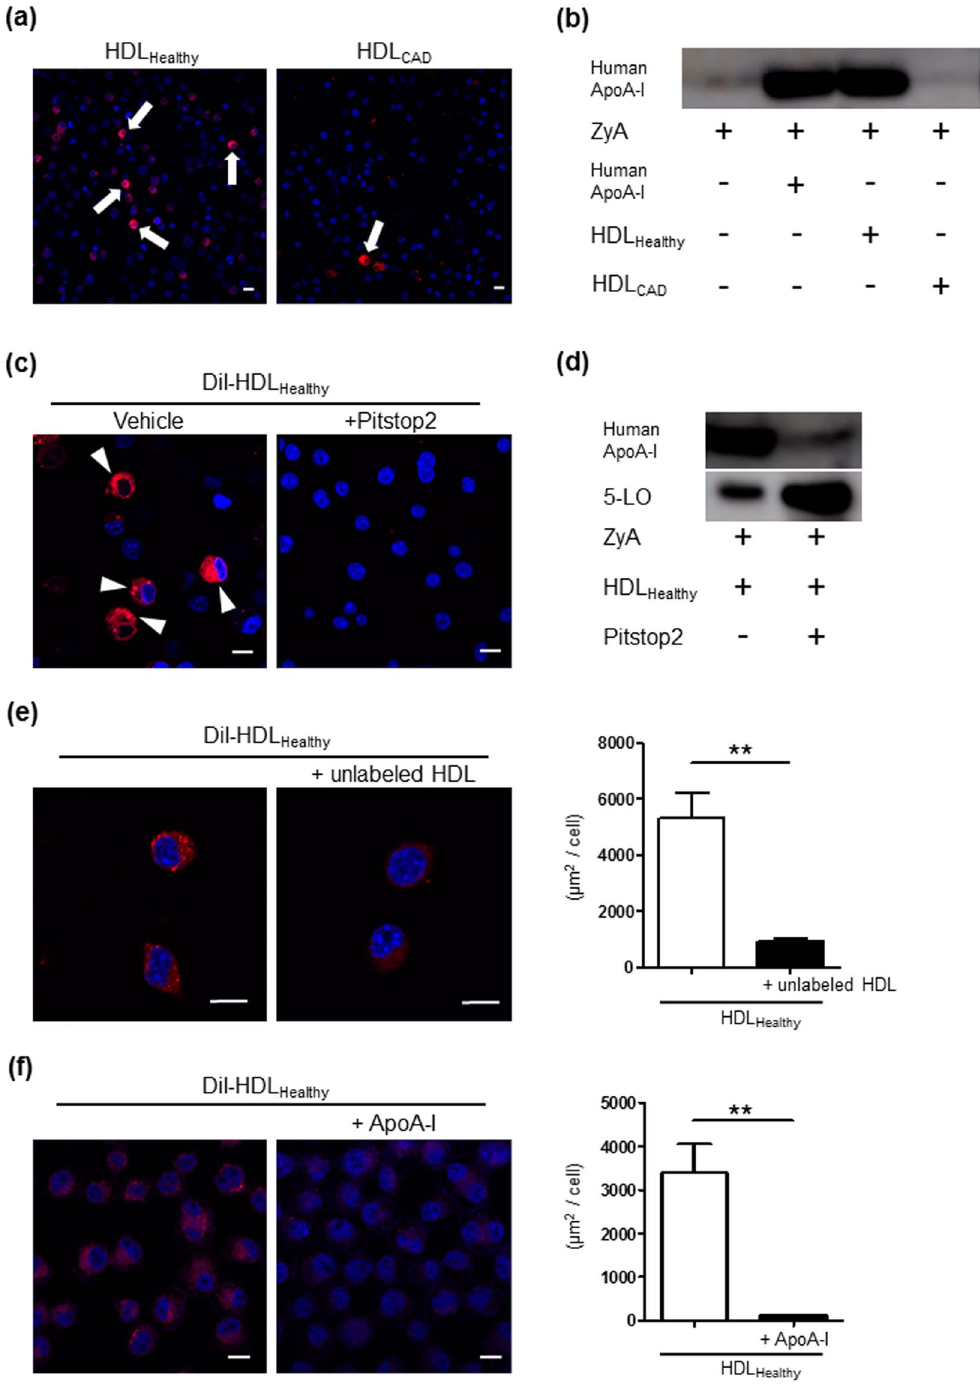
Figure 2. HDL Healthy , but not HDL CAD , was engulfed by macrophages through clathrin-mediated endocytosis. ( a ) Macrophages were incubated with DiI-labelled HDL (shown as red) for 30 min at 37 °C, then subjected to nuclear staining with DAPI (shown as blue). The arrows indicate HDL engulfment into macrophages (Scale bar = 10 μ m). ( b ) Activated macrophages (1 × 10 6 ) were co-incubated with human apoA-I (10 µ g) or each HDL (10 µ g) for 30 min at 37 °C. After extensive washing with PBS − / − , macrophages were harvested. Cell lysates were processed for western blot analysis of human apoA-I. The image is representative of results from N = 3 experiments. ( c ) Macrophages were incubated with DiI-labelled HDL (10 µ g) with or without 30 min pretreatment with the clathrin-mediated endocytosis inhibitor Pitstop 2 (20 μ M). The arrowheads indicate HDL engulfment into macrophages (Scale bar = 10 μ m). ( d ) Activated macrophages (1 × 10 6 ) were treated with HDL Healthy (10 µ g) for 30 min at 37 °C with or without pretreatment with 20 μ M Pitstop 2. After extensive washing, cell lysates were processed for western blot analysis of apoA-I and 5-LO. The image is representative of results from N = 3 experiments. ( e ) HDL Healthy engulfment was competitively blocked by unlabelled